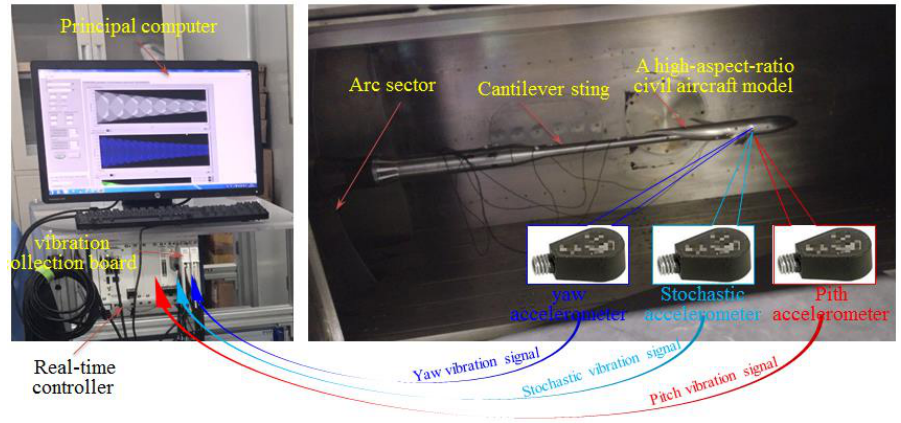
Figure 5. Real-time monitoring system of the stochastic multidimensional vibration.